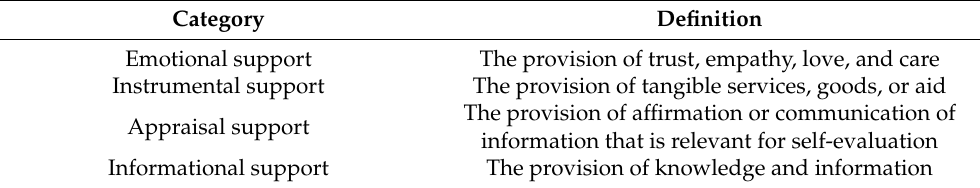
Figure 1. Provision of social support strategies categorized according to operational definitions (House 1981). Table 4. Definition and categorization of House (1981) social support framework.